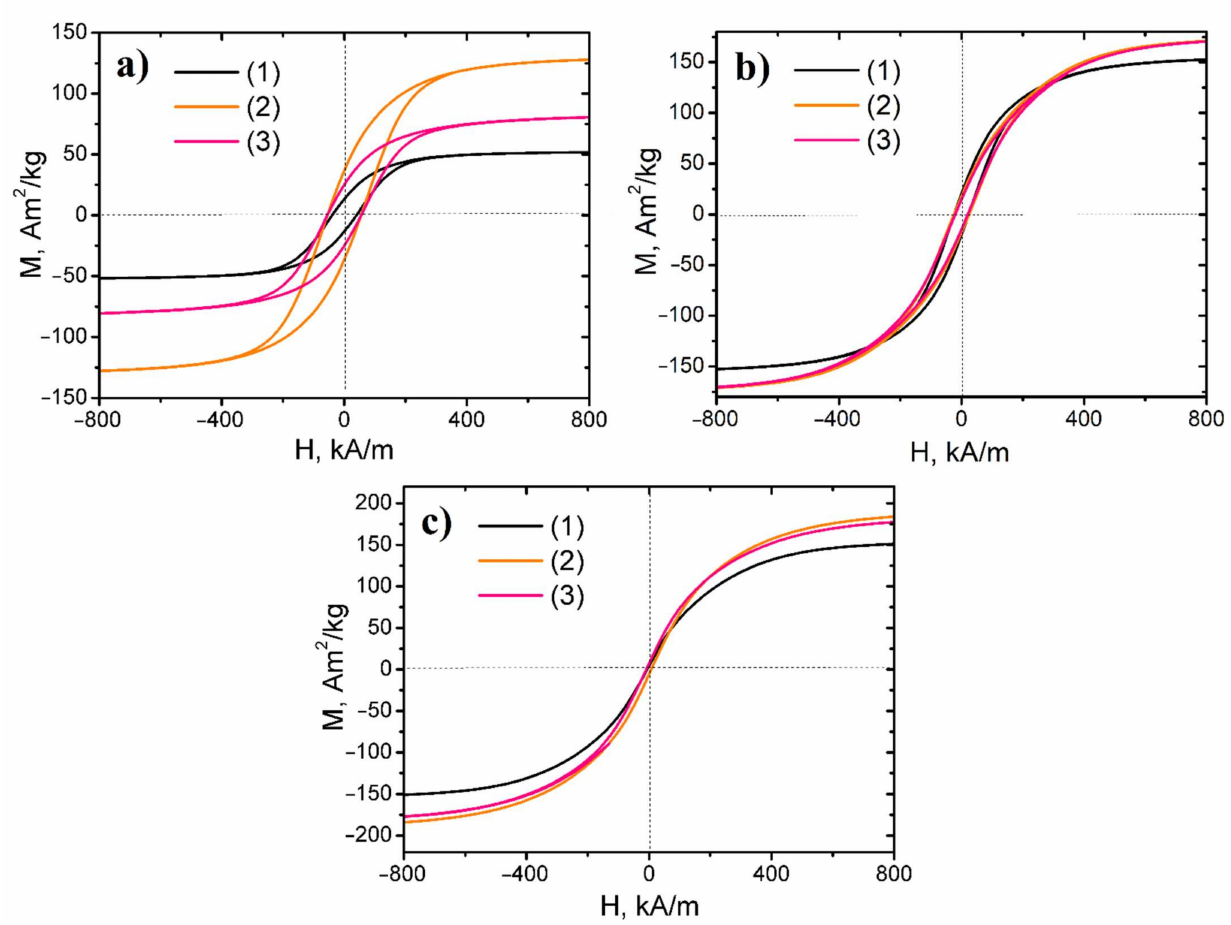
Figure 6. Hysteresis loops of Fe, Ni, and Co ternary system-based magnetic nanopowders: ( a ) reduced at 300 ◦ C series, ( b ) reduced at 400 ◦ C series, ( c ) reduced at 500 ◦ C series (1) Fe–Co–Ni samples, (2) 3Fe–Co–Ni samples, (3) 5Fe–Co–Ni